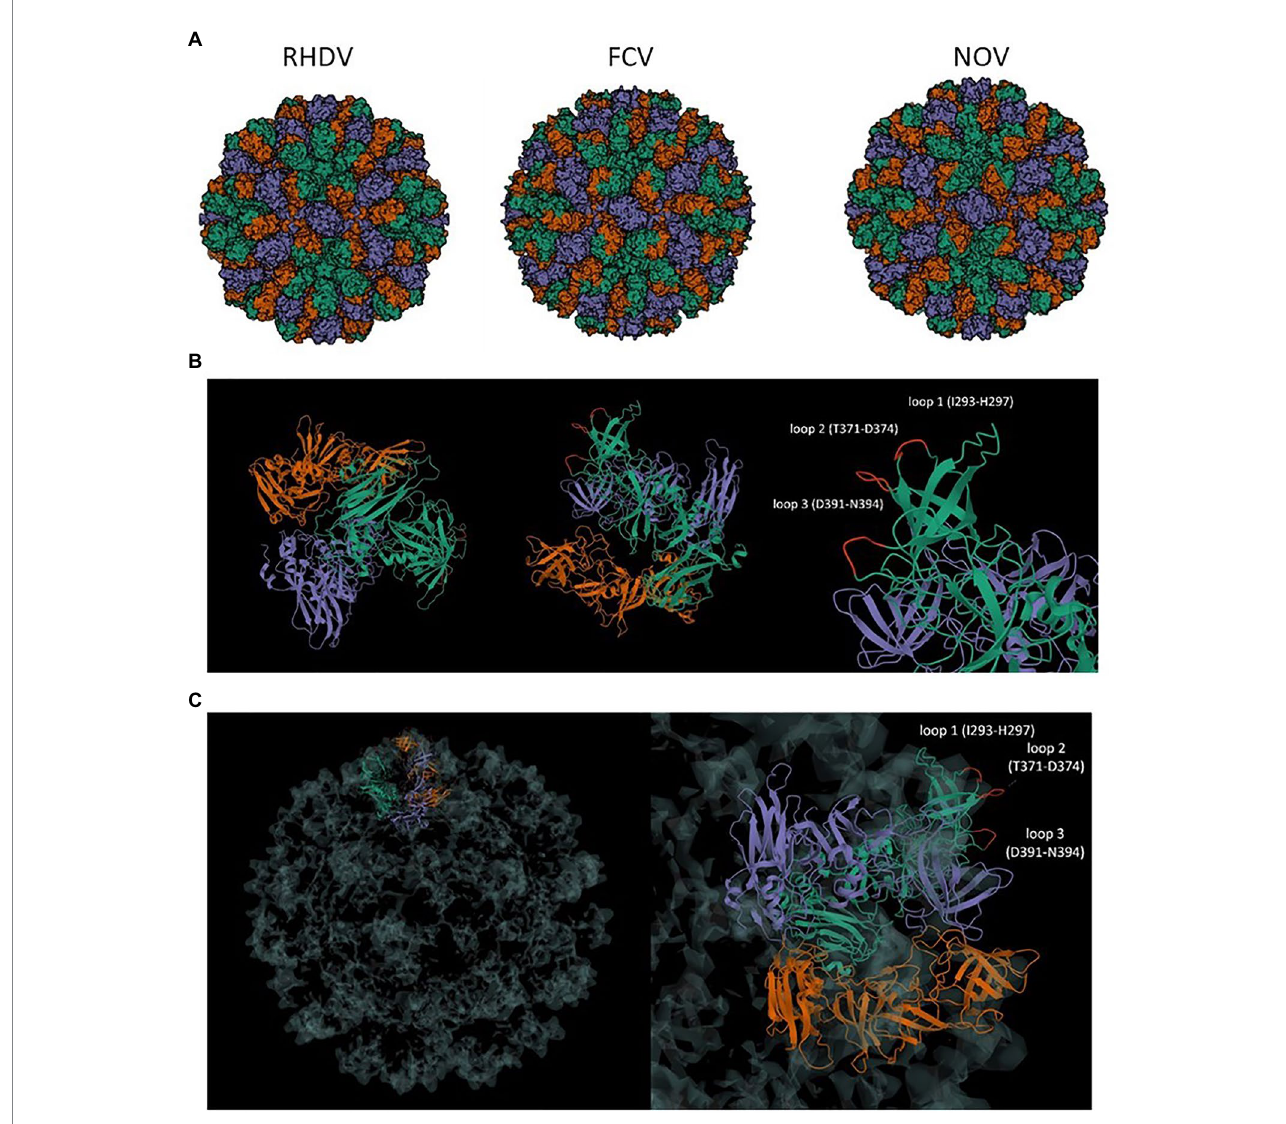
FIGURE 1 (A) Comparison of calicivirus VLP structure. Comparison of VLP of T = 3 symmetry of RHDV (PDB: 3J1P), FCV (PDB: 6GSH), and NoV (PDB: 7MRY); (B) VP1 asymmetric unit of NoV T = 3 VLP and localization of the surface loops 1–3; (C) Presentation of the VP1 asymmetric unit in T = 3 symmetry structure of VLP and the localization of loops for antigen insertion at the surface of the nanostructure; RHDV, rabbit hemorrhagic disease virus; FCV, feline calicivirus; NoV, norovirus.